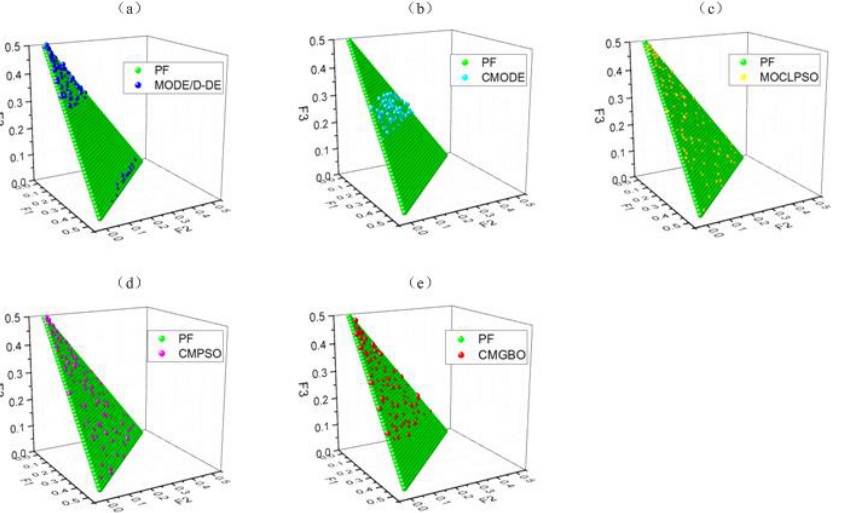
Figure 6. Non-dominated solutions of DTLZ1: ( a ) MOEA/D-DE; ( b ) CMODE; ( c ) MOCLPSO; ( d ) CMPSO; ( e ) CMGBO.